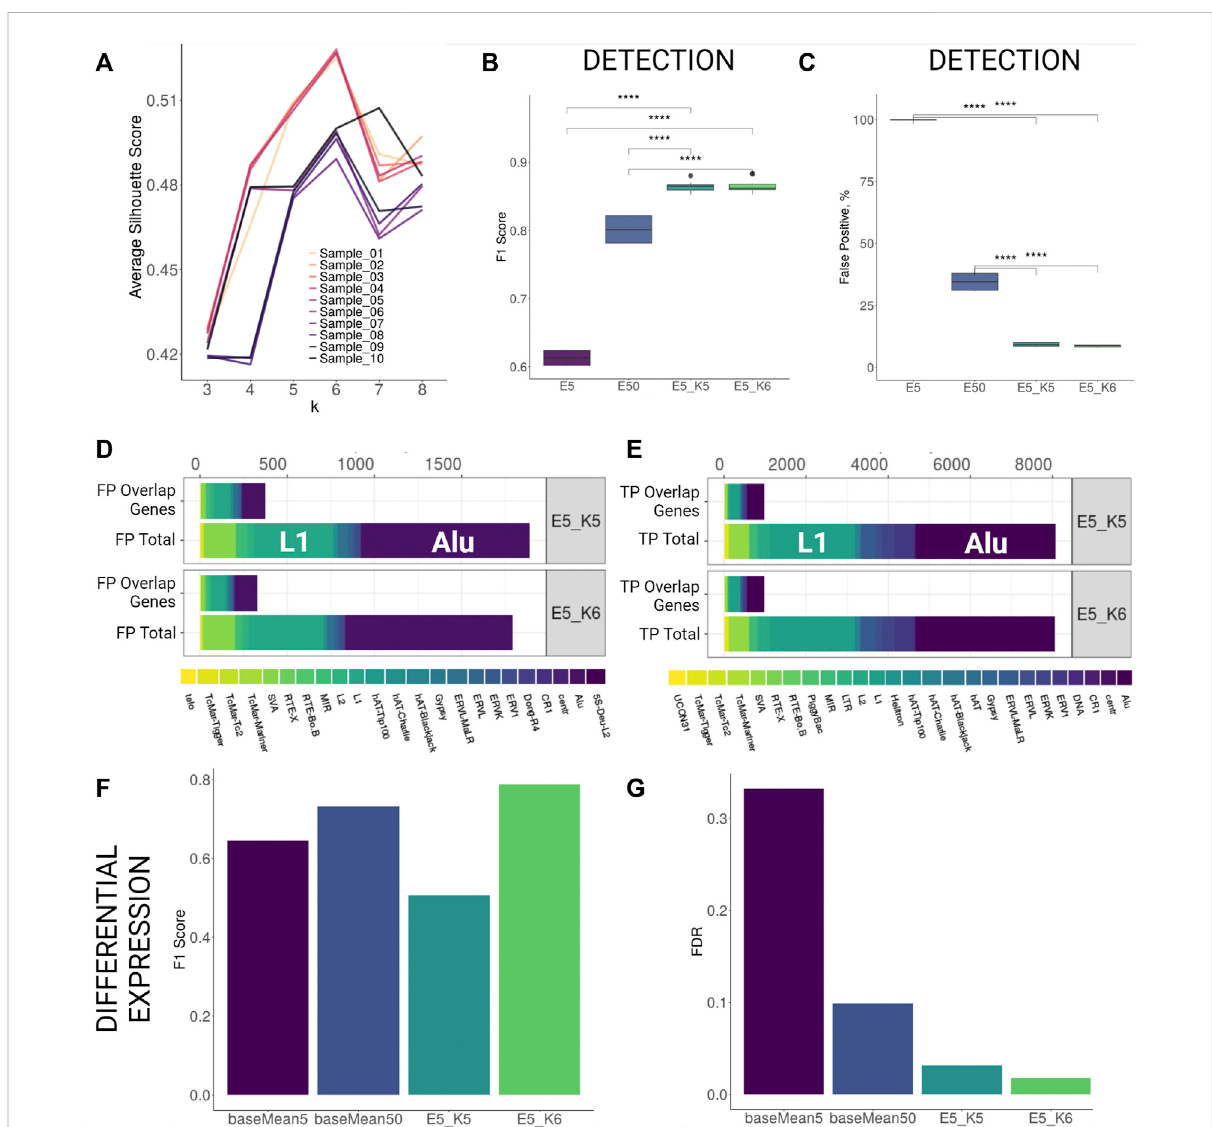
FIGURE 2 TSSpro fi lingimprovesdetectionanddifferentialexpressiondetectionforhumanstrandedsimulation. (A) Averagesilhouettescoresfordifferent k values per each sample. Best silhouette scores for most samples are reached with k = 5 and k = 6. (B,C) F1 Score and False Positive proportions improvement with TSS pro fi ling at the detection level. Both parameters improve signi fi cantly (Wilcoxon signed-rank test, p < 0.001) when TSS pro fi ling is applied to elements retained with detection cutoff 5 (E5_K5 and E5_K6) as compared to only fi ltering by low detection cutoff (5counts,E5)orincreasingdetectioncutoff(50counts,E50). (D,E) FamilyCompositionofFPandTPhitscategorizedbytotalandoverlapgenesafter TSS pro fi ling (F,G) F1 Score and FDR improvement for differential expression detection with TSS pro fi